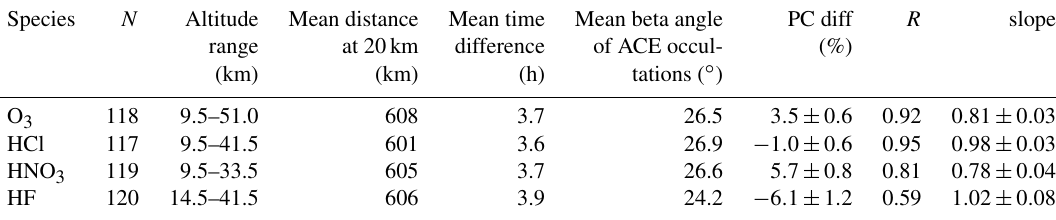
Table 4. Comparison of ACE-FTS v3.5 and PARIS-IR partial columns (2006–2013) for the stratospheric gases presented in this study. N is the number of coincident pairs used in this calculation. The third column gives the altitude range of the partial columns used for this comparison, the fourth column shows the mean distance between the observed air masses from the instruments along the line of sight at 20km. The mean time between the observations is displayed in the fifth column and the mean beta angle of the ACE observations in the sixth column. The seventh column (PC diff) represents the mean differences in the partial columns between the FTSs (in %) along with the standard error. The correlation coefficient ( R ) and the slope of the regression plot (slope), along with the 1 σ uncertainty of the slope, are shown in columns 8 and 9, respectively. Species N Altitude Mean distance Mean time Mean beta angle PC diff R slope range at 20km difference of ACE occul-